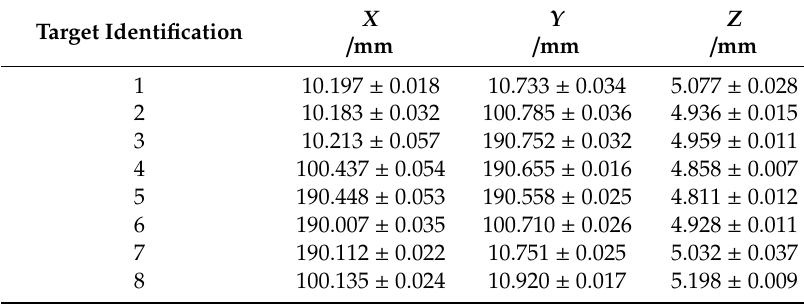
Table 2. Three-dimensional spatial coordinates of the reference targets—referential B.